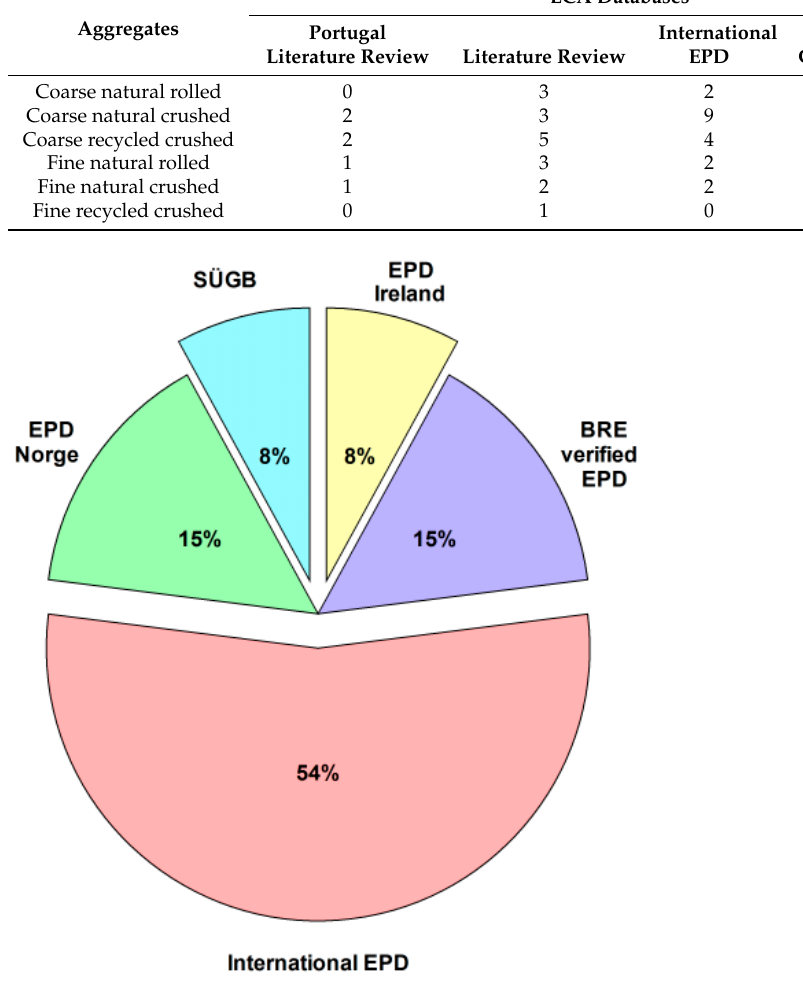
Figure 2. Program operators of the EPD. Table 3. Generic